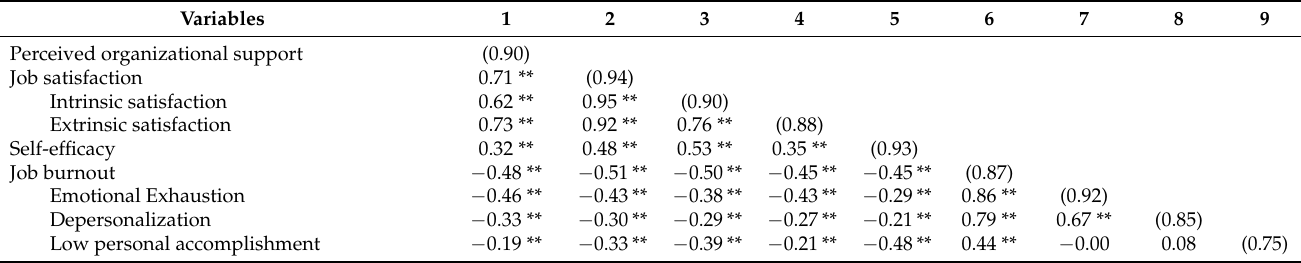
Table 4. Correlations of variables and sub-variables.